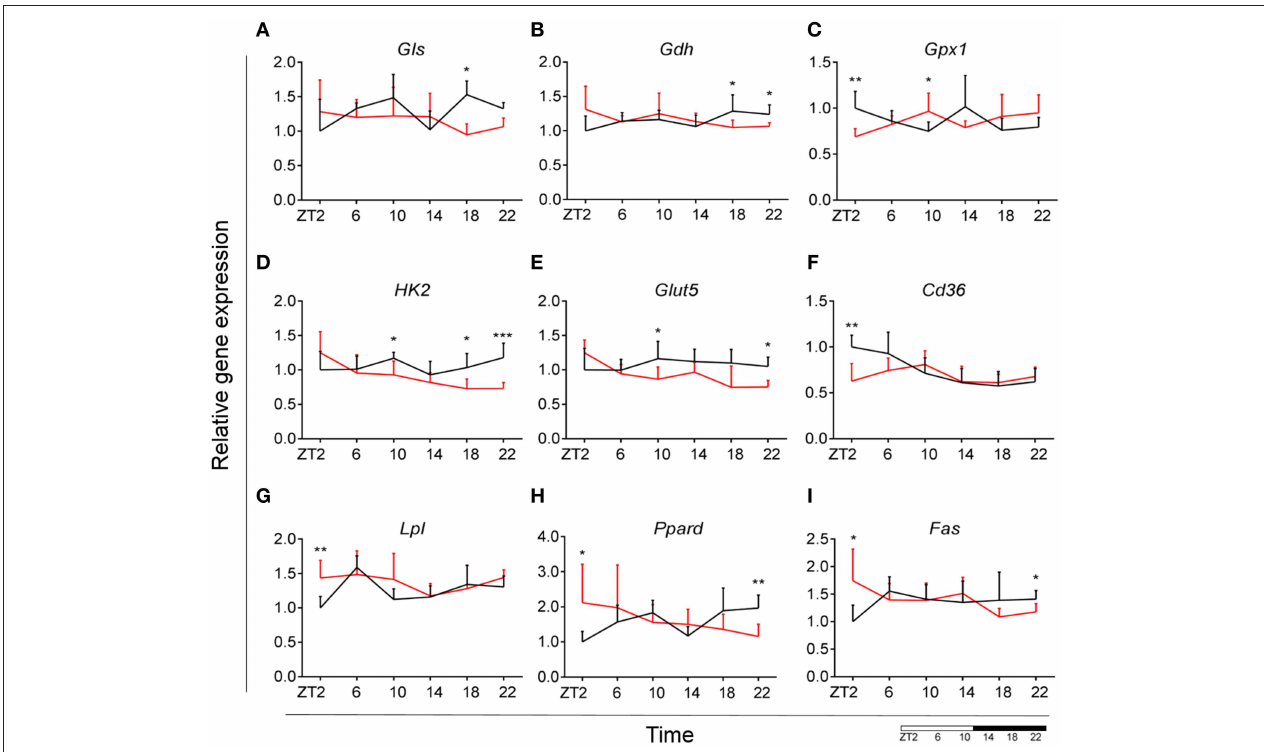
FIGURE 5 | HFD effect on glutamate, glucose and lipid microglial metabolism in rats. Relative gene expression of (top) glutamate substrate utilization genes Gls (A) and Gdh (B) , as well as antioxidant enzyme gene Gpx1 (C) ; (middle) glucose metabolism genes Hk2 (D) and Glut5 (E) , fatty acid sensing gene Cd36 (F) ; (bottom) fatty acid sensing genes Lpl (G) and Ppard (H) , as well as fatty acid synthesis gene Fas (I) in HFD-fed rats (red) compared to Chow-fed controls (black) evaluated at six time points, starting at ZT2. Data are presented as means ± SEM. Statistical significance was determined using Two-way ANOVA effect for Interaction , Diet, and Time (ZT); Student t -test is used for diet effect within a separate time point (* p < 0.05; ** p < 0.01; *** p < 0.001). Scale (bottom right) represents light (ZT0-12) and dark (ZT12-24)